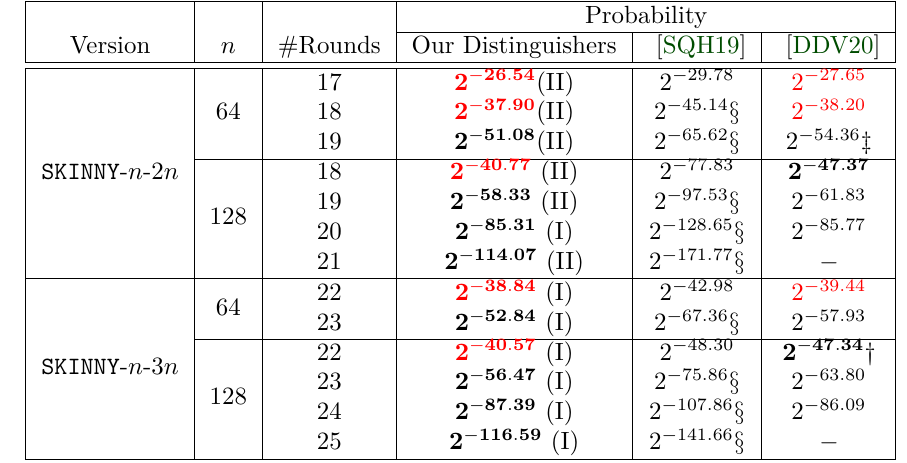
Table 8: Summary of our results in comparison to the results in [SQH19] and [DDV20] for boomerang distinguishers of SKINNY . The probabilities highlighted in red have been verified experimentally. The Roman numbers represent the corresponding distinguisher in our paper. The probabilities denoted by § , correspond to the distinguishers that can be obtained by extending the distinguishers proposed in [SQH19]. The probabilities displayed with a † sign correspond to the distinguishers from [DDV20] that are exactly the same as our distinguishers and the probabilities represented with a ‡ sign are associated to the distinguishers from [DDV20] having the same activeness pattern as our